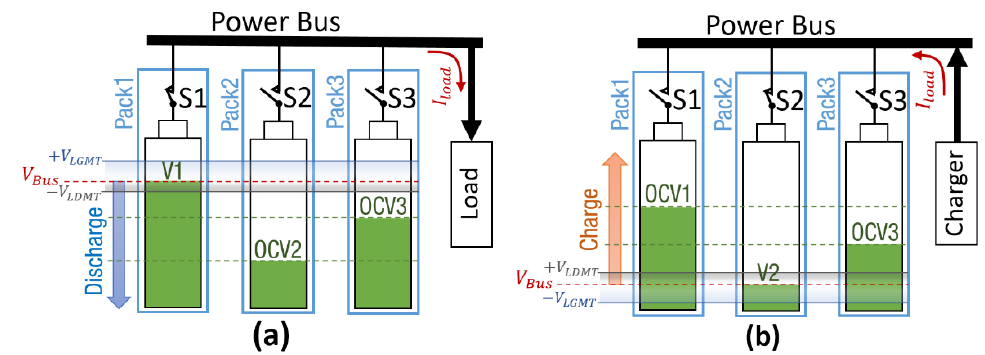
Figure 4. Schematic of battery pack mounting operation. ( a ) Mounting process during discharging. ( b ) Mounting process during charging.